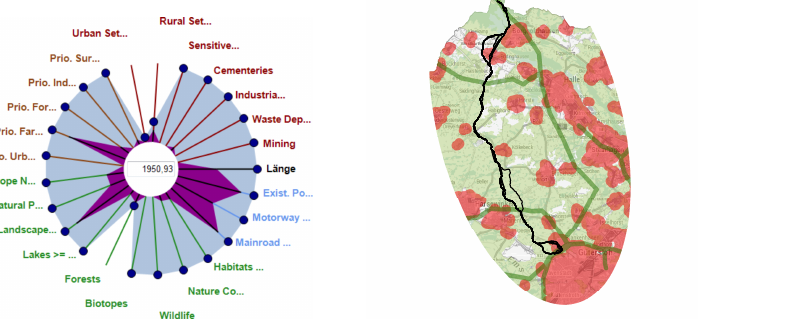
( a ) Spider-Plot: Solutions with little impact on settlements and Forests